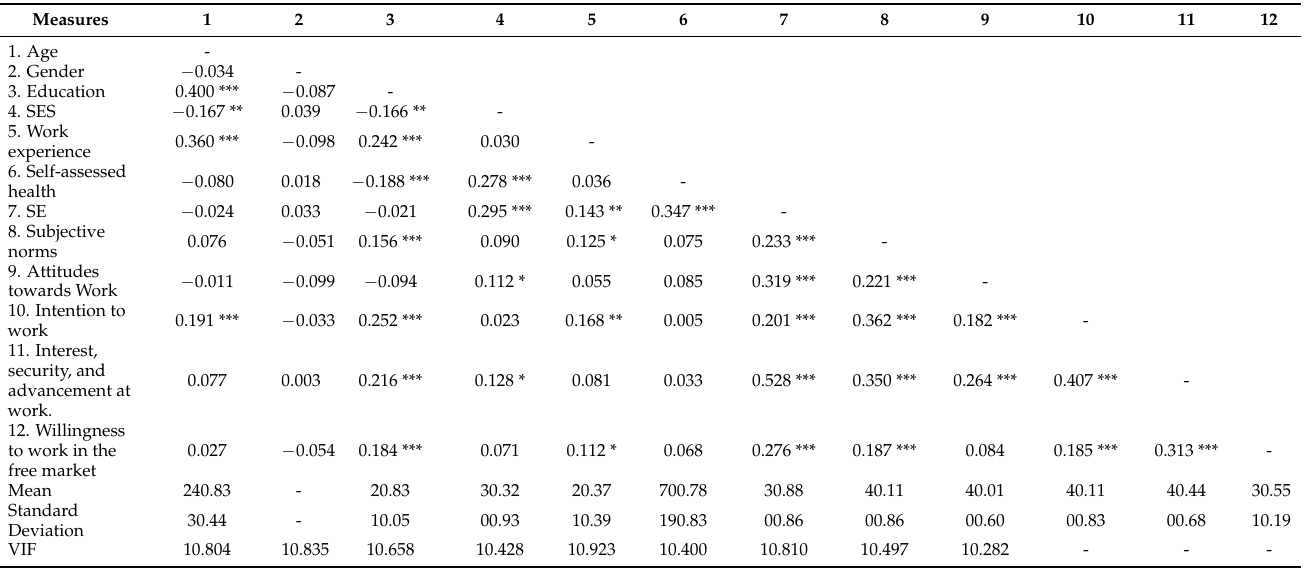
Table 3. Variable